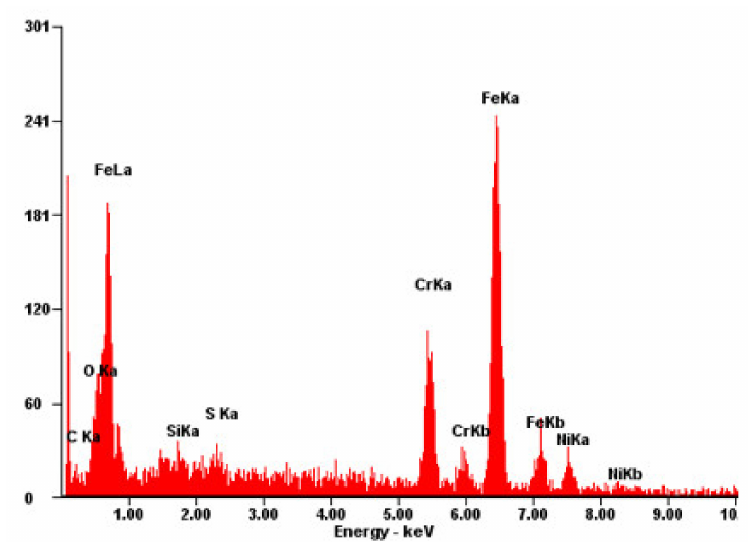
Figure 12. The EDS analysis result for the area that is indicated in Figure